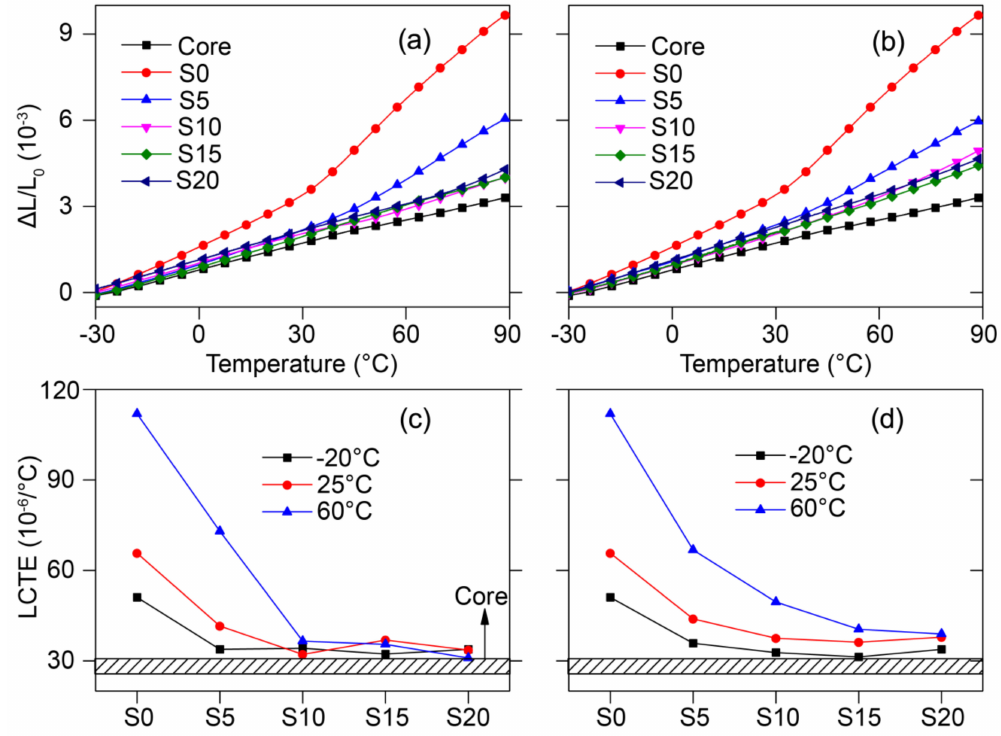
Figure 4. Thermal expansion strain of the cut Co-WPCs in the extrusion direction: ( a ) nSiO 2 and ( b ) mSiO 2 fillers in shell layer, and LCTE as a function of silica content: ( c ) nSiO 2 and ( d ) mSiO 2 fillers in the shell layer.